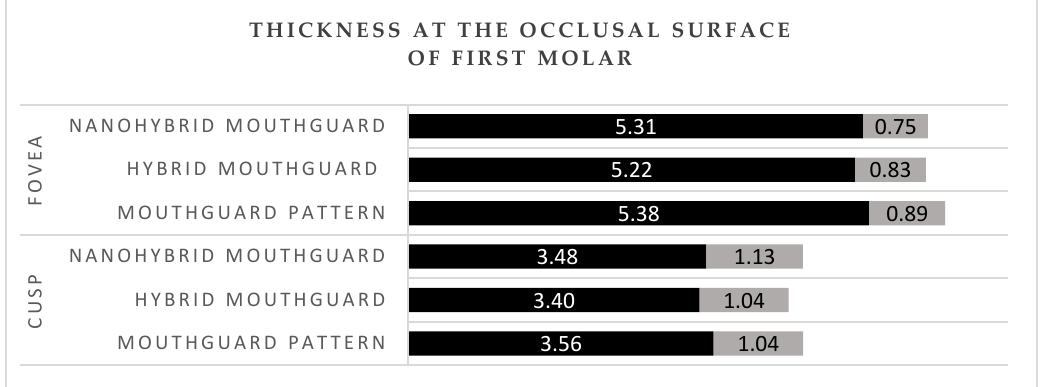
Figure 6. Thickness at the occlusal surface of first molar. Black—mean value; grey—standard deviation (SD).